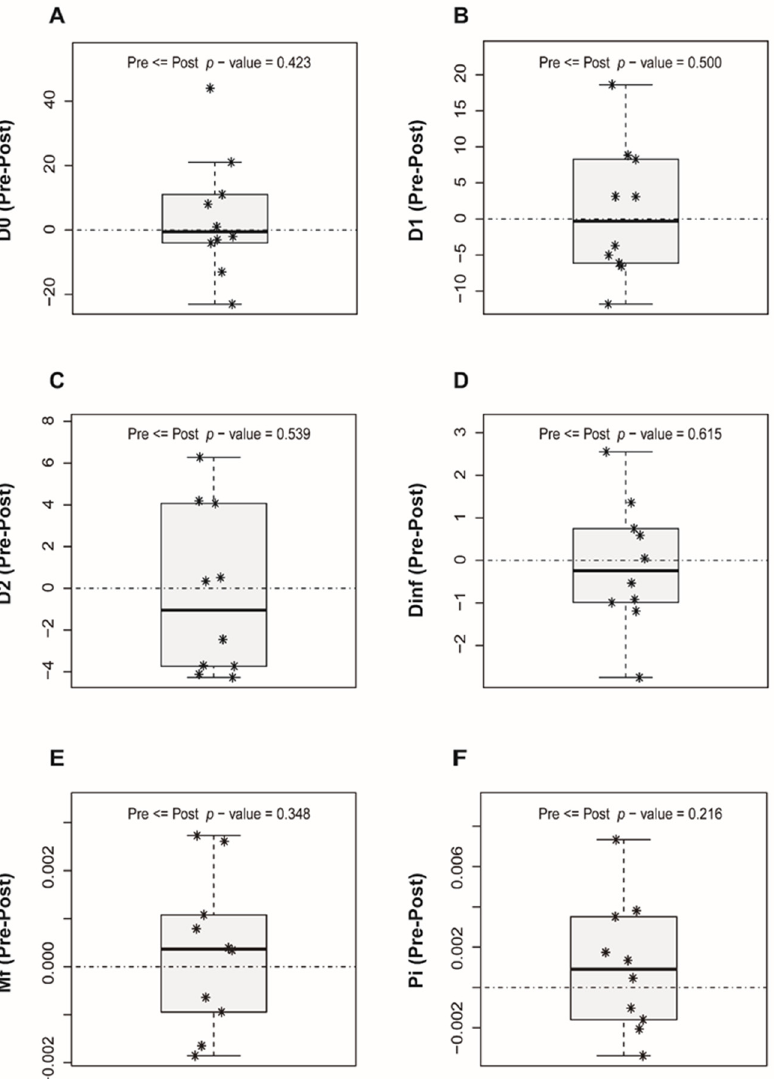
Figure 2. Boxplots with diversity indices showing differences between the pre-LT and post-LT quasispecies. ( A ) D0: hill number of order 0, ( B ) D1: hill number of order 1, ( C ) D2: hill number of order 2, ( D ) Dinf: hill number of order infinity, ( E ) Mfmax: mutation frequency, ( F ) π : nucleotide diversity. Each patient is represented as *. The p -value resulting from the Mann-Whitney U -test is included.